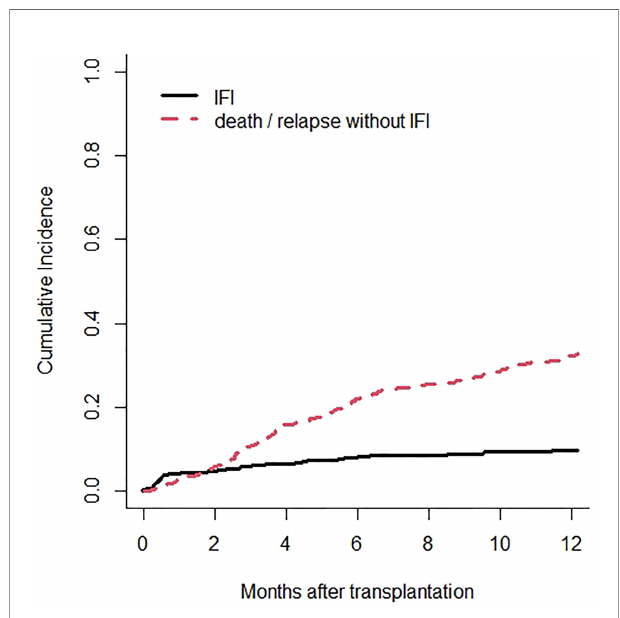
FIGURE 1 | Cumulative incidence rate of invasive fungal infections (IFIs) is 9.6% at 12 months after transplant on the whole cohort. Death or relapse without IFIs are considered the competing